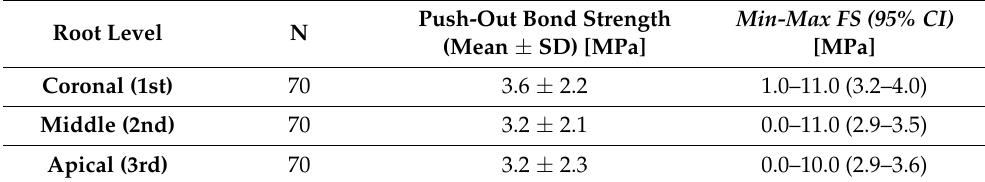
Table 3. The mean bond strength values (mean ± standard deviation (SD)) (in MPa), Minimum, Maximum, and 95%-Confidence Interval of mean bond strength values of all post systems divided by three root levels longitudinally (coronal, middle, and